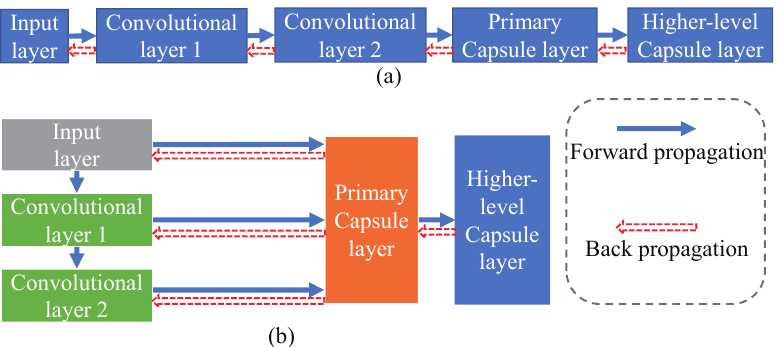
Figure 3. Schematic diagram of constructing the primary capsule layer. ( a ) Traditional method. ( b ) Proposed method.